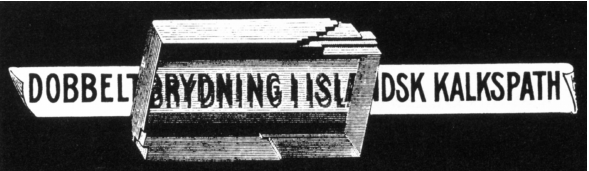
Figure 1. Double refraction in a cleavage rhombohedron of Ice- landic calcite. The relative displacement of the images is about a tenth of the specimen thickness. Such pictures appeared in various 20th century European textbooks on optics; this one was reproduced in the Danish magazine Naturens Verden (Vol. 69, p. 363, 1985).